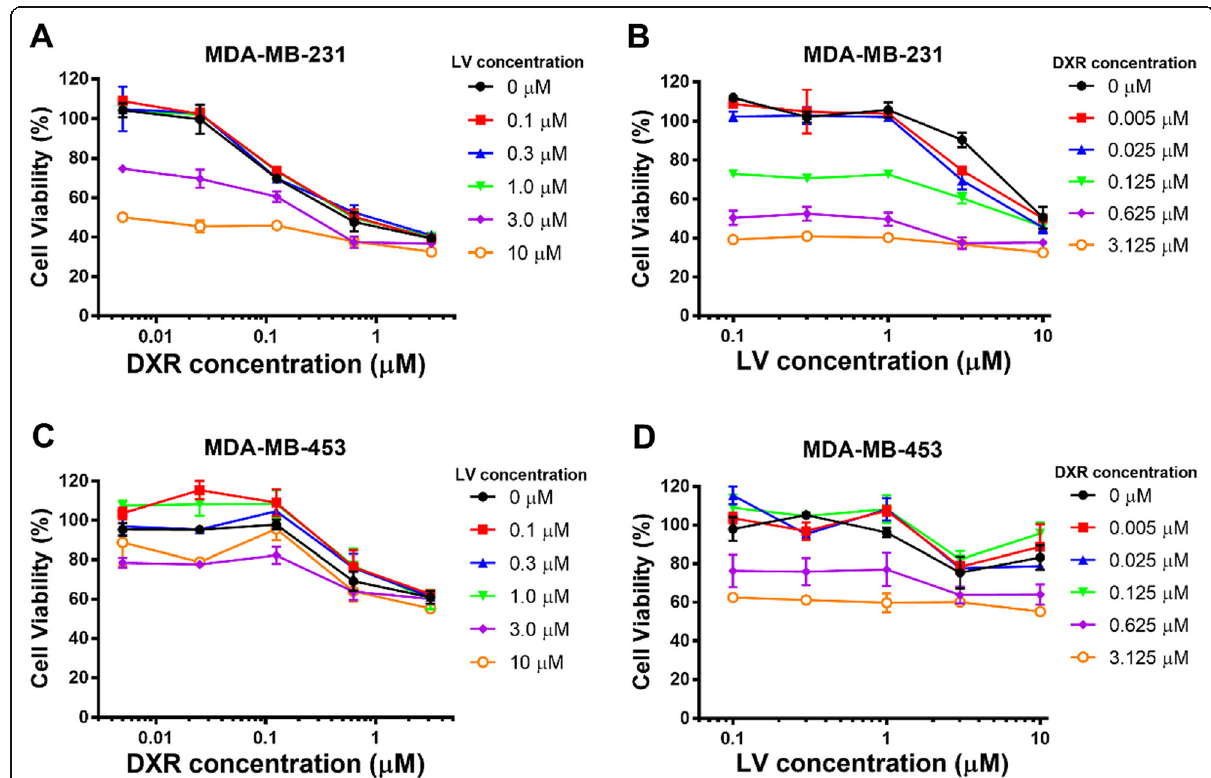
Fig. 1 Cytotoxicity of free doxorubicin (DXR) and free lovastatin (LV) in breast cancer cells. In vitro cytotoxicity of free DXR, LV, and DXR and LV combined against MDA-MB-231 ( a , b ) and MDA-MB-453 ( c , d ) cancer